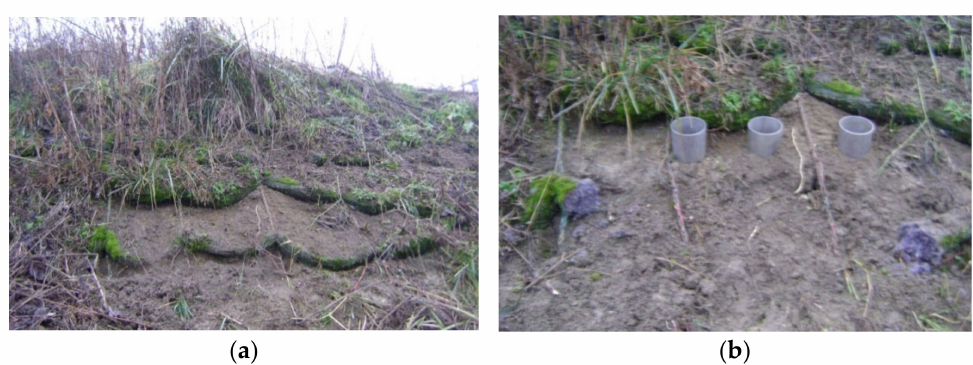
Figure 5. Sampling on 18 January 2020 at location 4. ( a ) The lower rope with three sections (left section, LS; center section, CS; right section, RS). ( b ) The sample cylinders and the cut-off rope for the rope tension strength determination and scanning electron microscopy